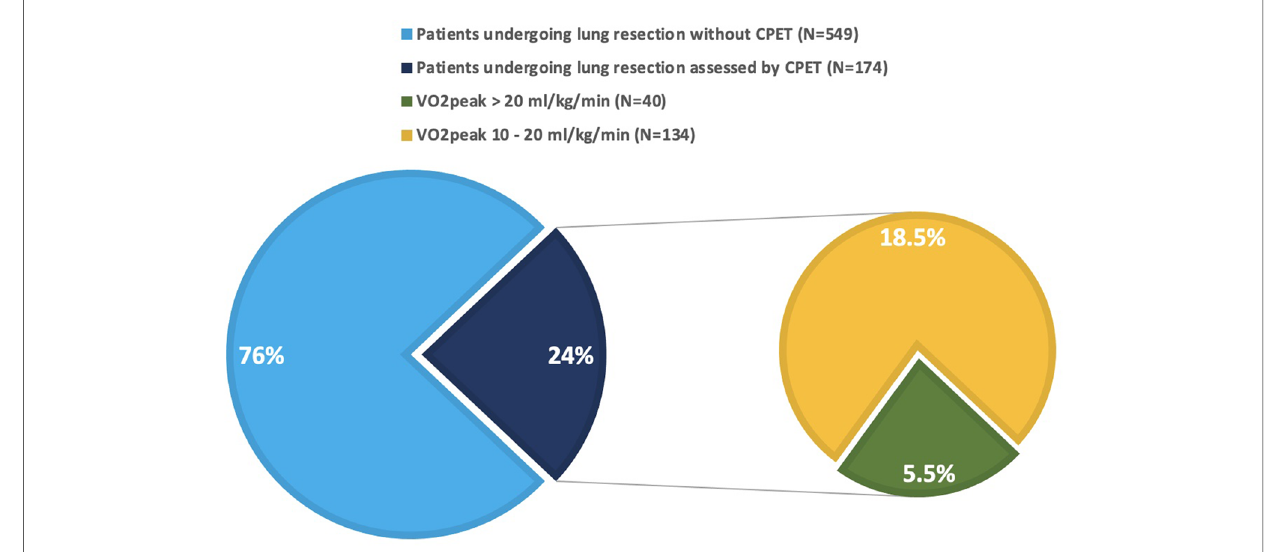
FIGURE 1 Patients undergoing lung resection for pulmonary nodules during the study period. Green slice represents the patients included in the analysis (5.5% of the whole population, 23% of the patients assessed by